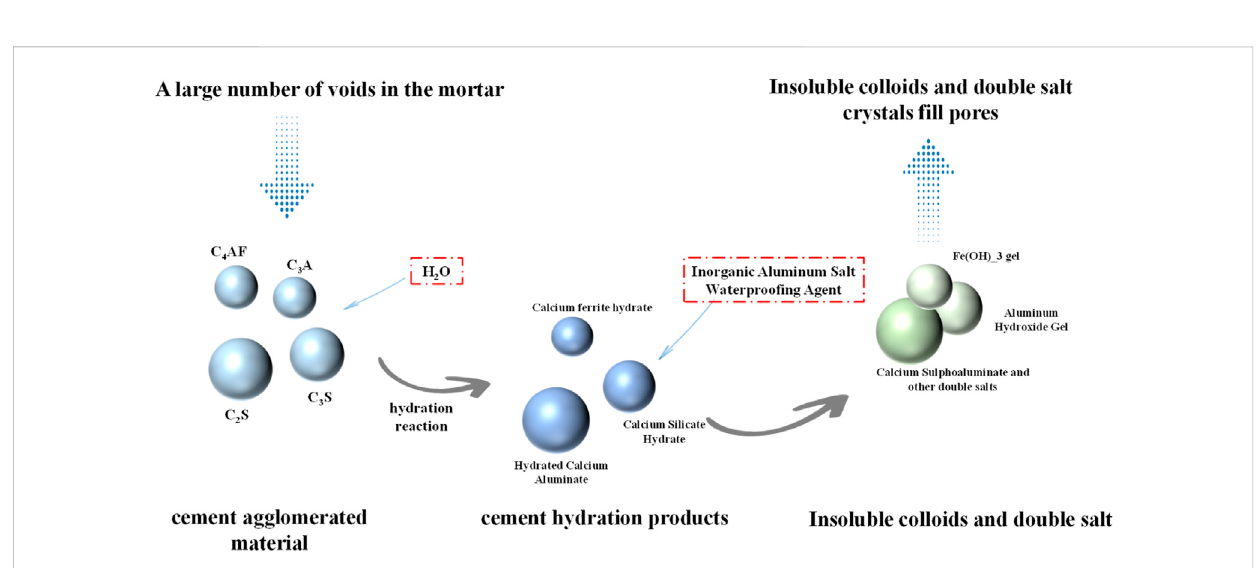
FIGURE 12 Protective mechanism of inorganic aluminum salt waterproo fi ng